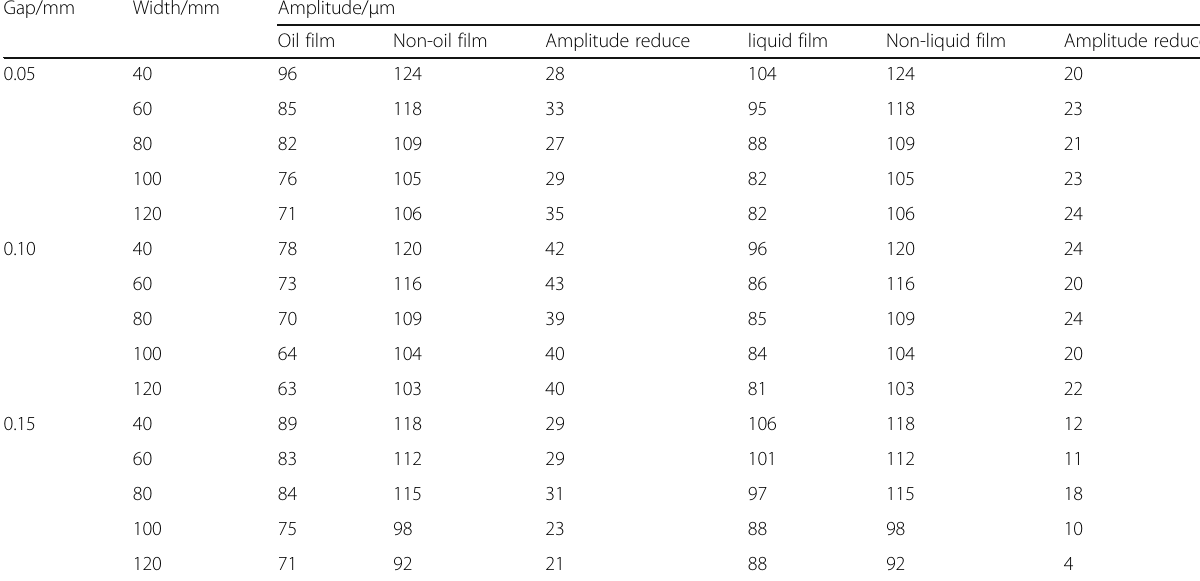
Table 2 Single damping oil film, liquid membrane effects on spindle amplitude Gap/mm